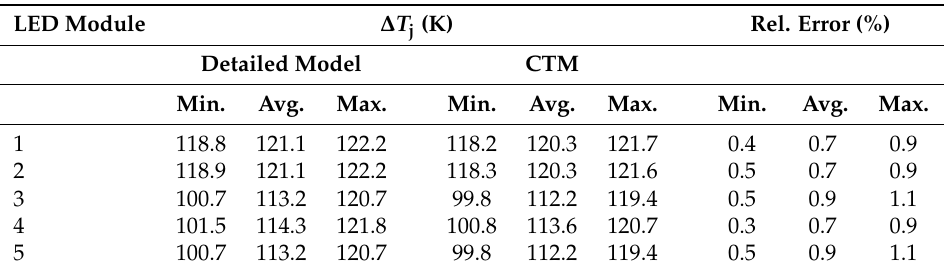
Table 4. Minimum, average, and maximum junction temperature rises and relative errors for each of LED modules in the LED luminaire-level